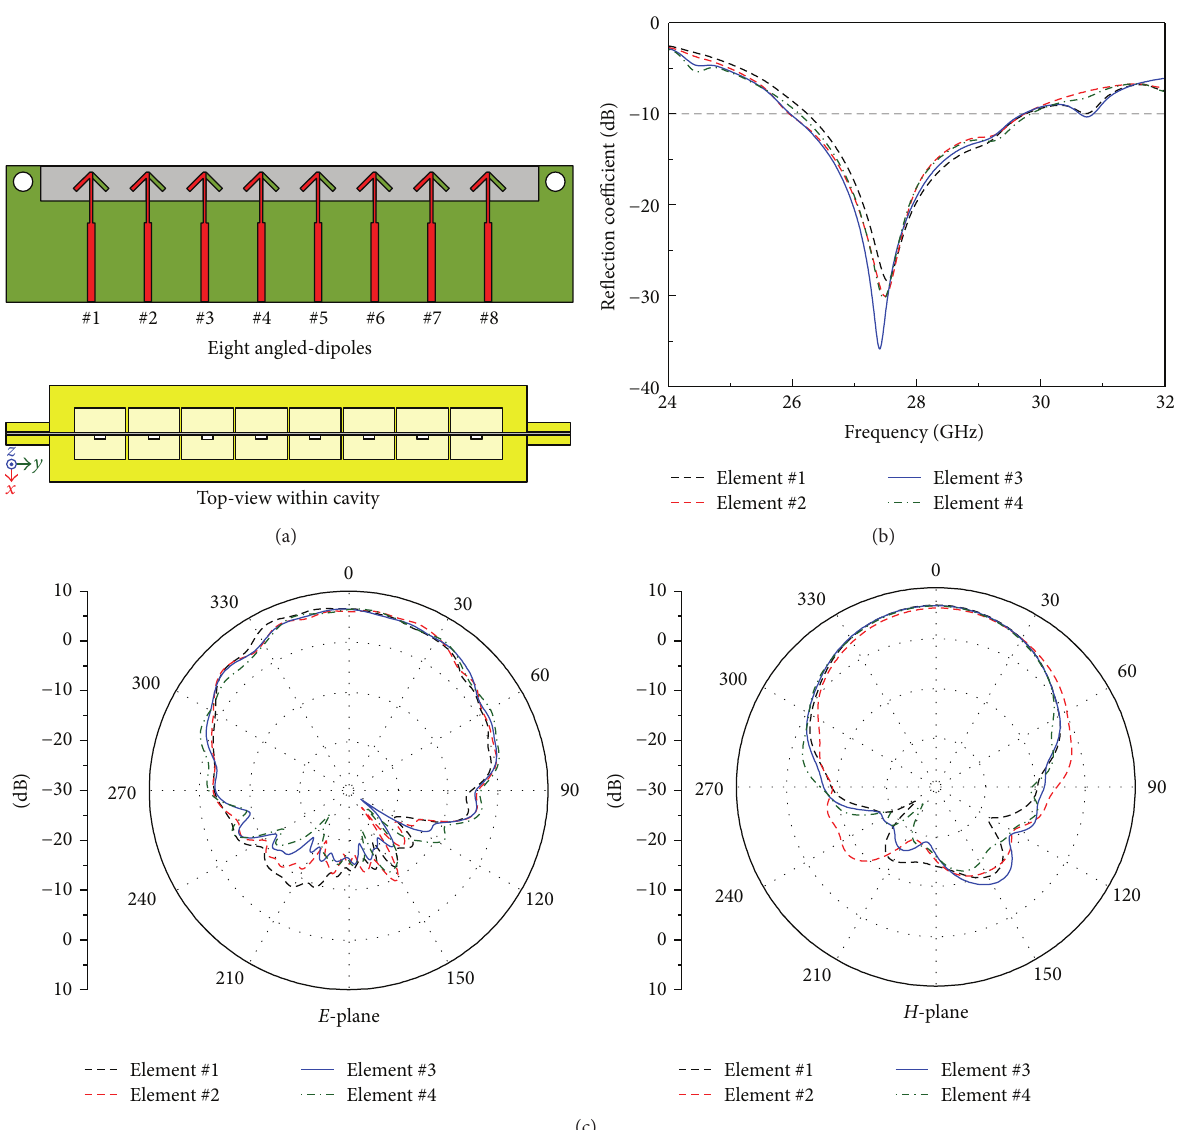
Figure 5: (a) Geometry of an eight-element linear array with the proposed antenna and a center-to-center spacing of 5.6 mm. Simulated (b) | values and (c) active patterns for the different |𝑆 11